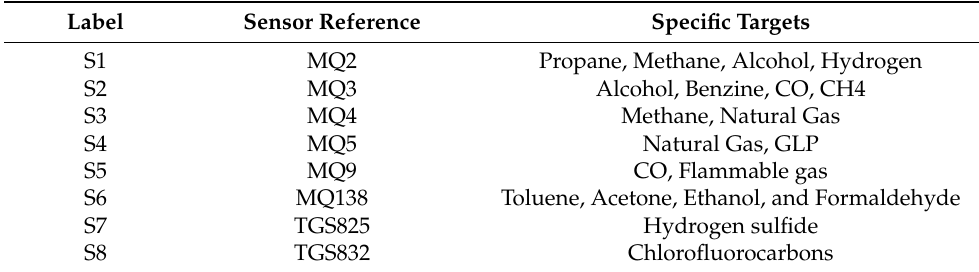
Table 2. Chemical-resistive sensors for the Electronic Nose (E-nose).